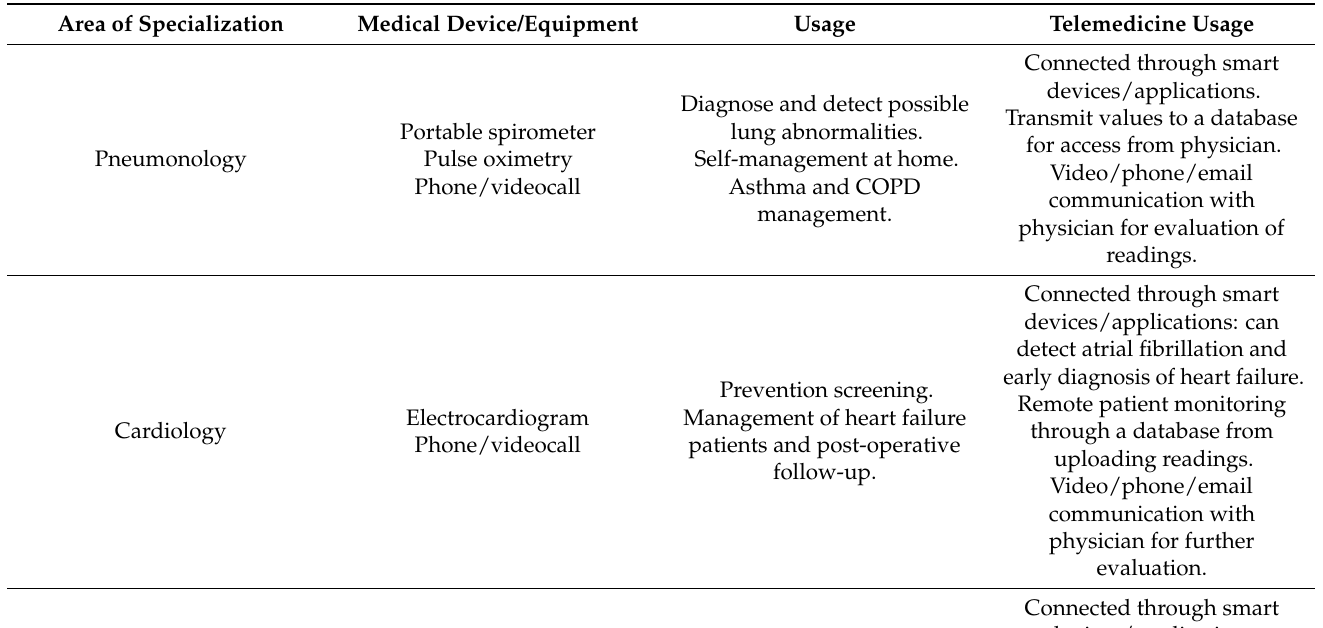
Table 1. Summary of medical device/equipment used for telehealth purposes by medical specializa-